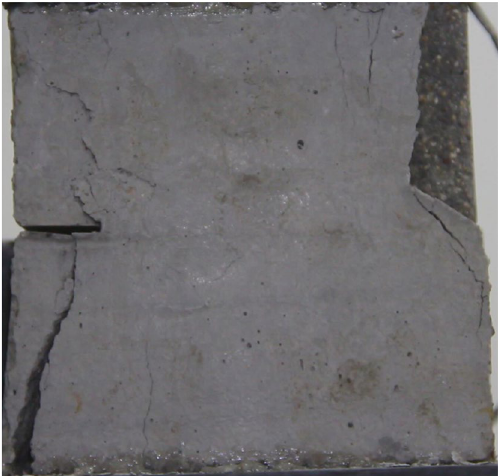
Figure 51. Photograph of a specimen showing tensile wing crack and tensile crack from the top surface caused by compression appearing.